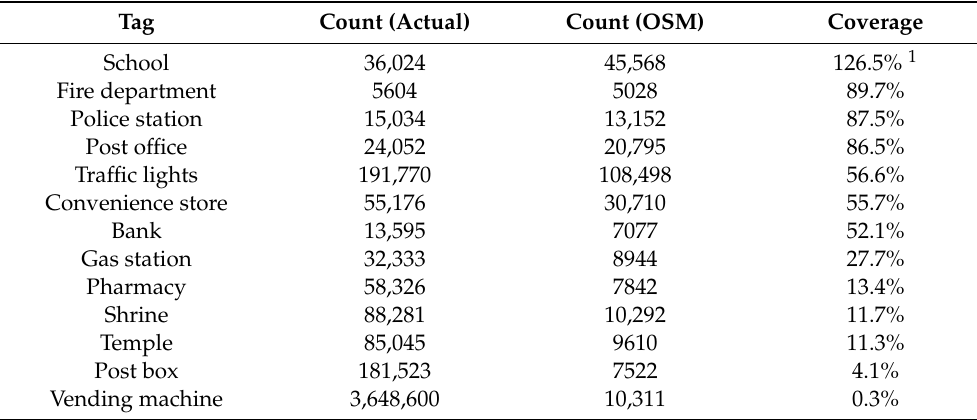
Figure 2. Excerpt of OSM [left] and Geospatial Information Authority of Japan (GSI) base map [right]. Note the inconsistency in completeness for OSM, in contrast to the GSI data. Table 1. Coverage of OSM tags in Japan 2017 [18].